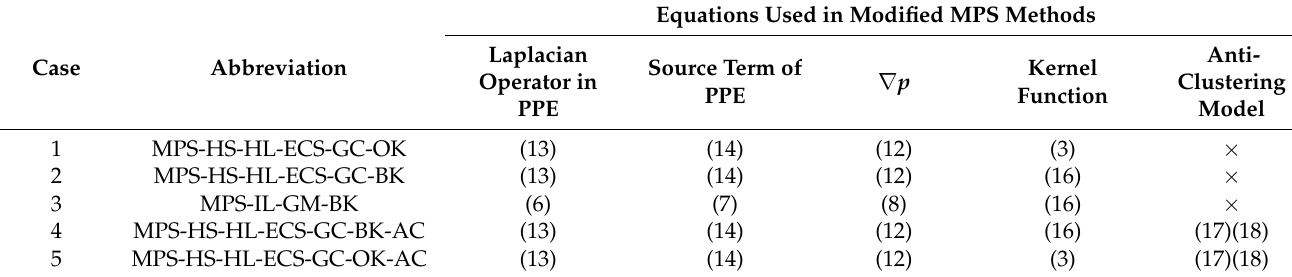
Table 1. Cases of the selected stability enhancement methods’